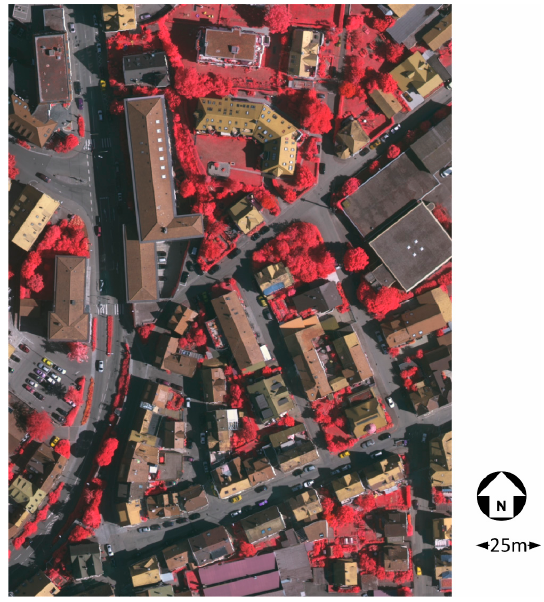
Figure 7. DSM-based ortho-image (false-color).